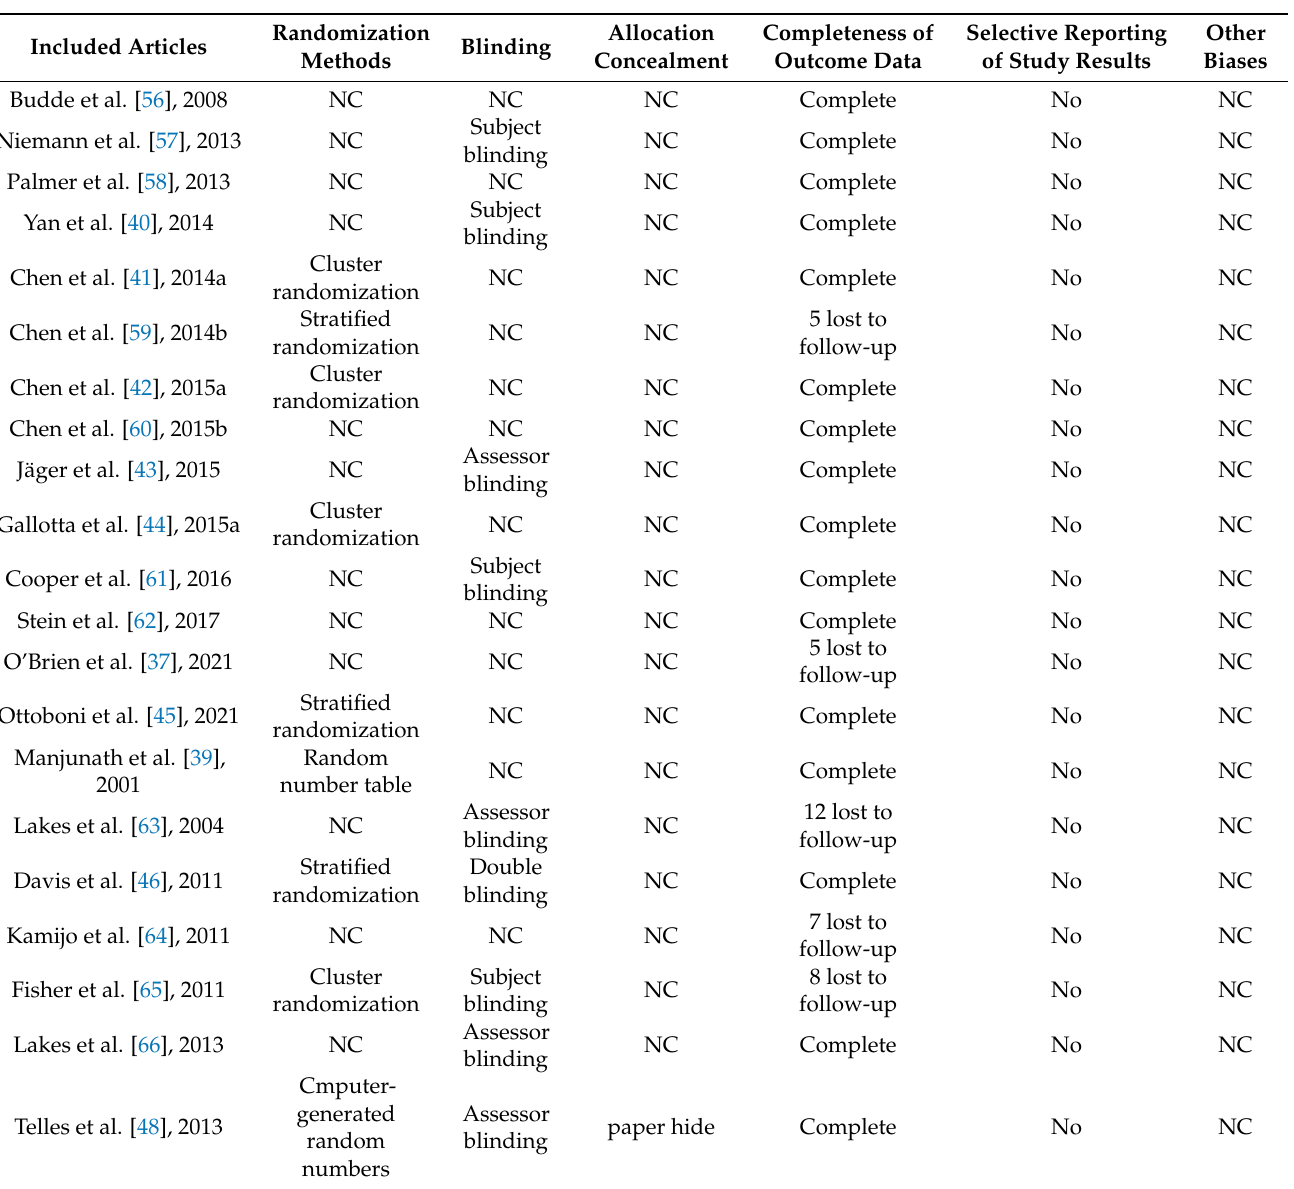
Table 2. Results of the quality assessment of the included RCTs and